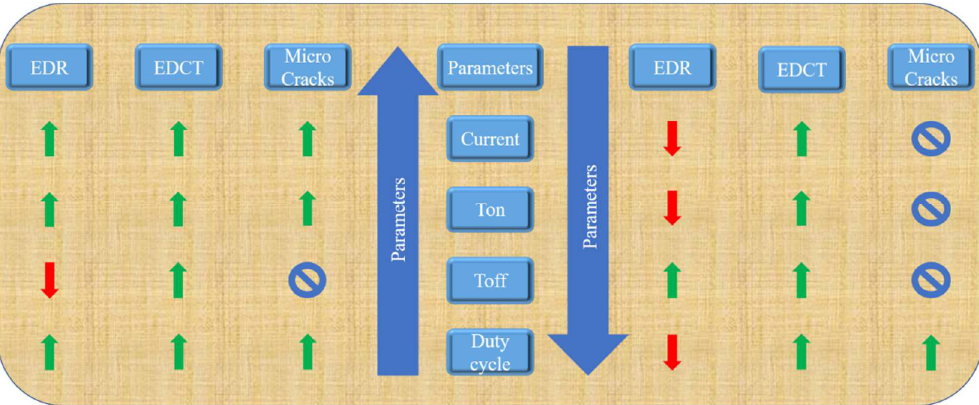
Figure 12. Output parameters response with respect to input parameters response.